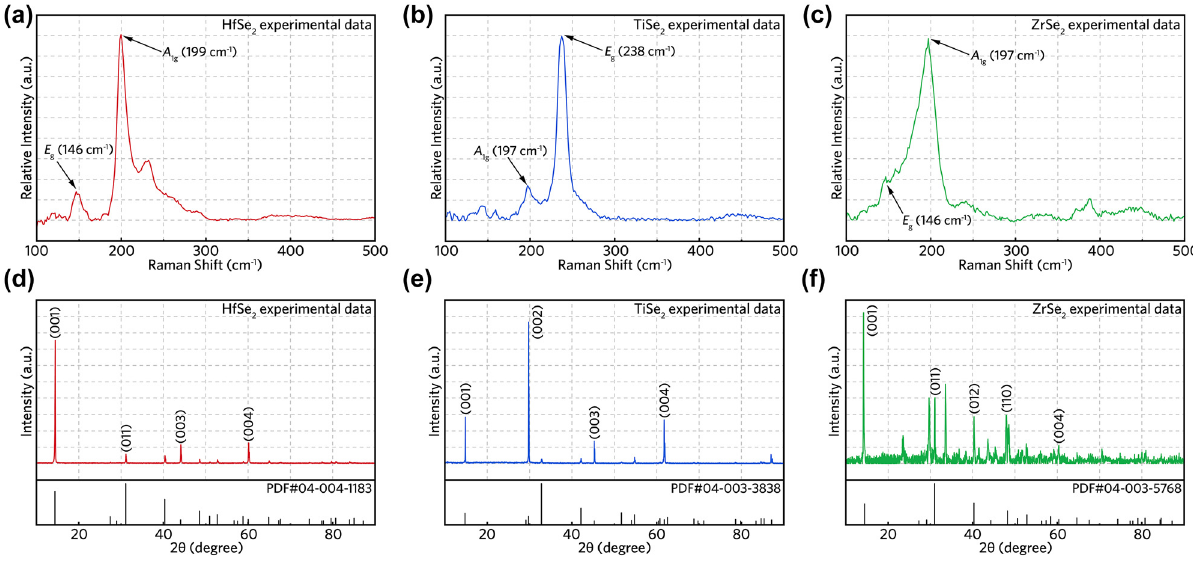
Figure 2: Raman spectral and XRD analysis. (a)–(c) Raman spectrums of HfSe are experimental data and the black line represents standard PDF